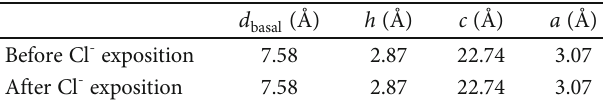
Table 4: Structural parameters calculated for